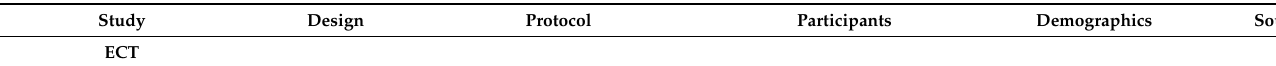
Table 2. Clinical studies included: characteristics and individual